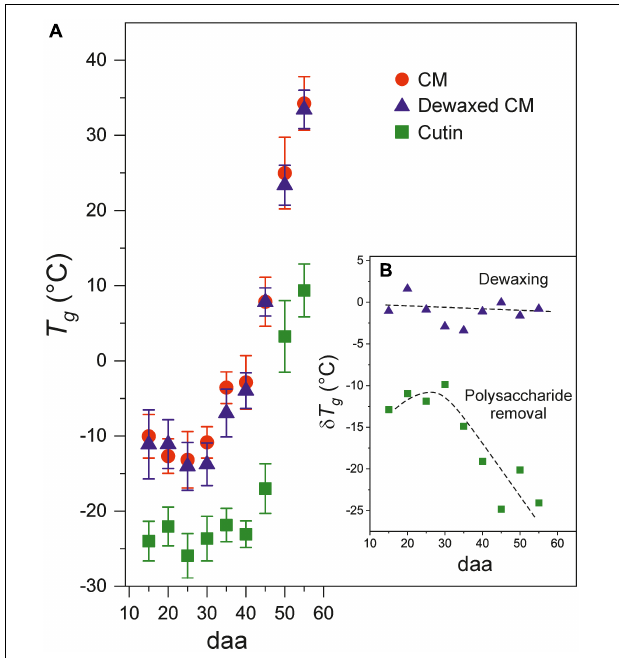
FIGURE 4 | (A) Evolution of T g for CMs, dewaxed CMs and cutins along fruit development. (B) T g variation ( δ T g ) after dewaxing (triangles) and polysaccharide removal (squares) from cuticle membranes. Error bars represent ± 1 SE.